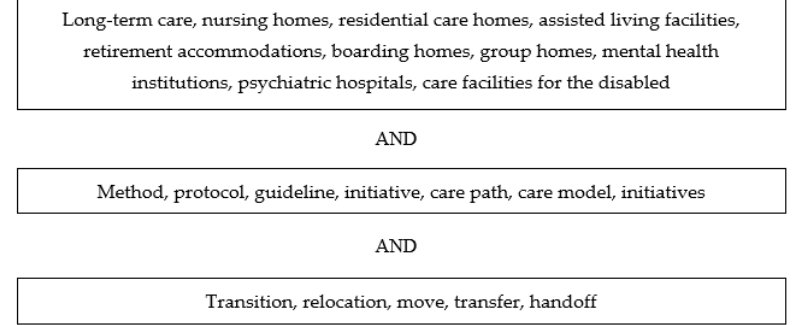
Figure 1. Search